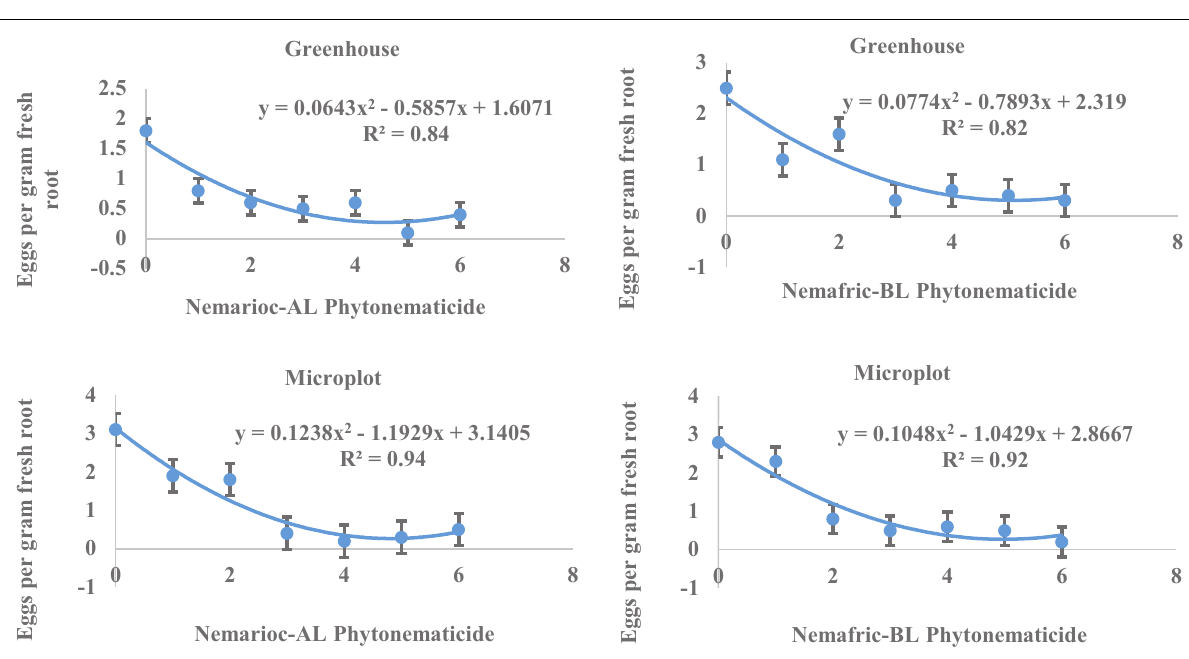
FIGURE 2 | Response of M. incognita eggs in root of pea seeds primed in cucurbitacin phytonematicides and seedlings raised in greenhouse and microplot conditions (Bar represents mean ± standard error) (The x-axis comprised transformed data, where 0 = 0%, 1 = 2%, 2 = 4%, 3 = 8%, 4 = 16%, 5 = 32%, and 6 = 64%